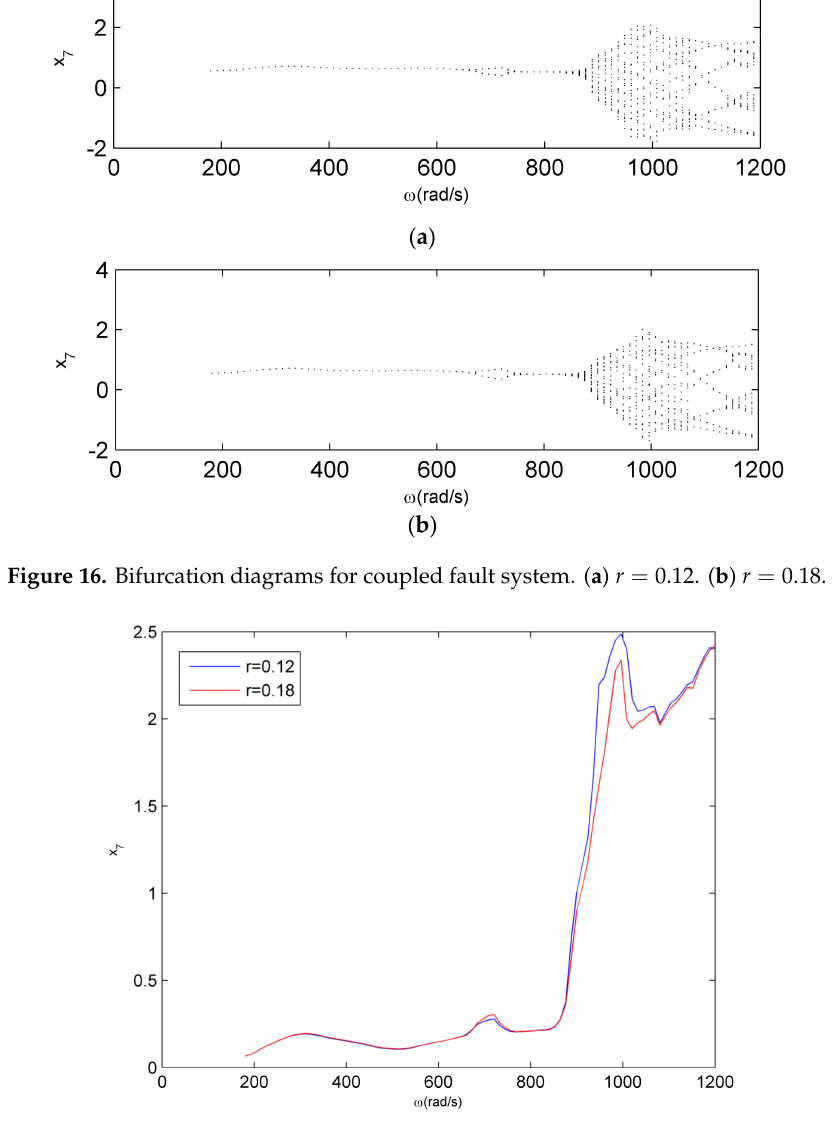
Figure 17. Comparison of the amplitude–frequency